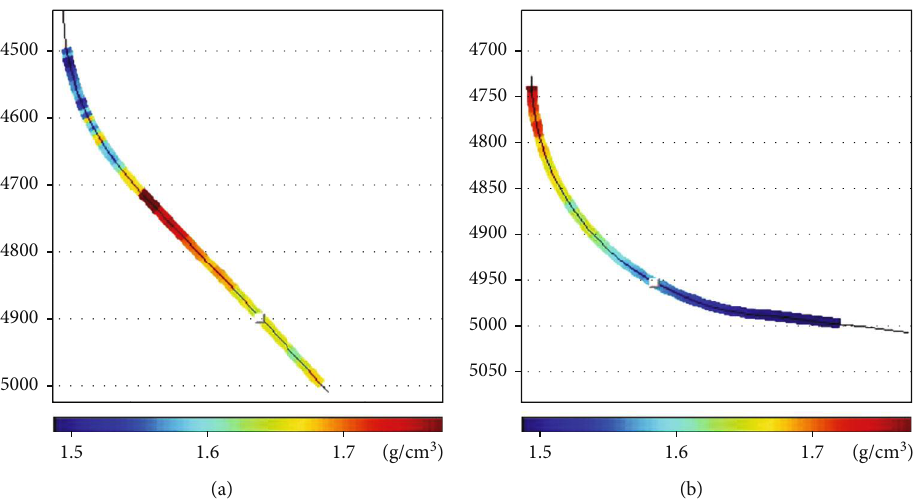
Figure 14: Simulation of the safe drilling fl uid density window of the well trajectory with di ff erent well deviation angles.